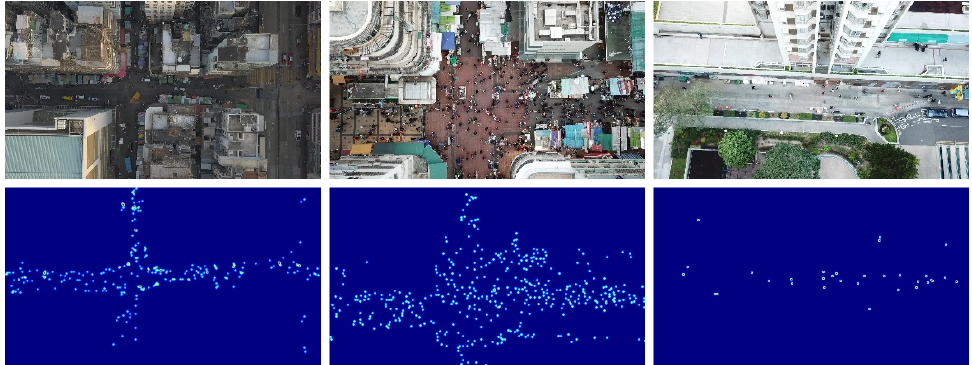
Figure 1. Sample Gaussian-kernel density maps generated from UAV-view